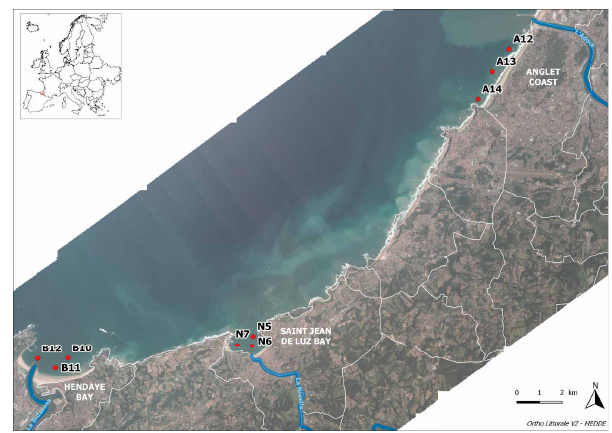
Figure 1: Geographical location of the sampling sites along the French Basque